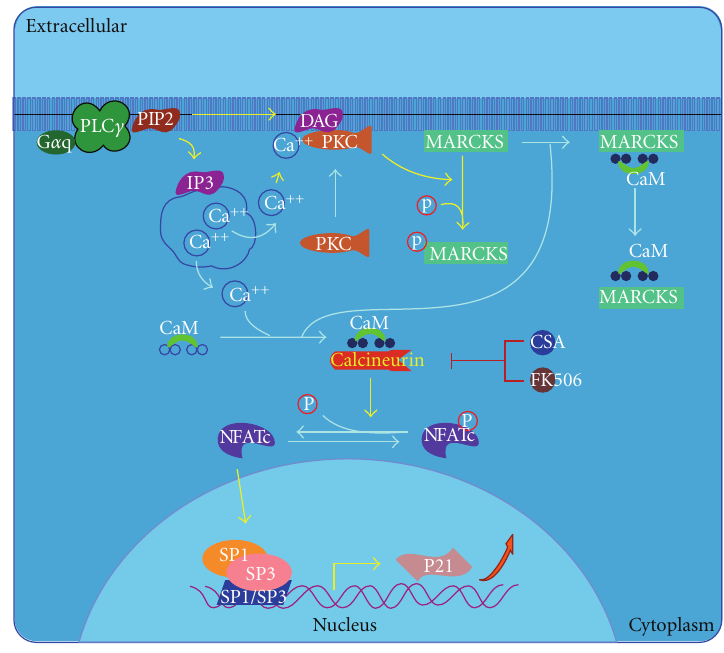
Figure 4: E ff ects of calcineurin in keratinocyte di ff erentiation pathway extracted from BioCarta database [9].